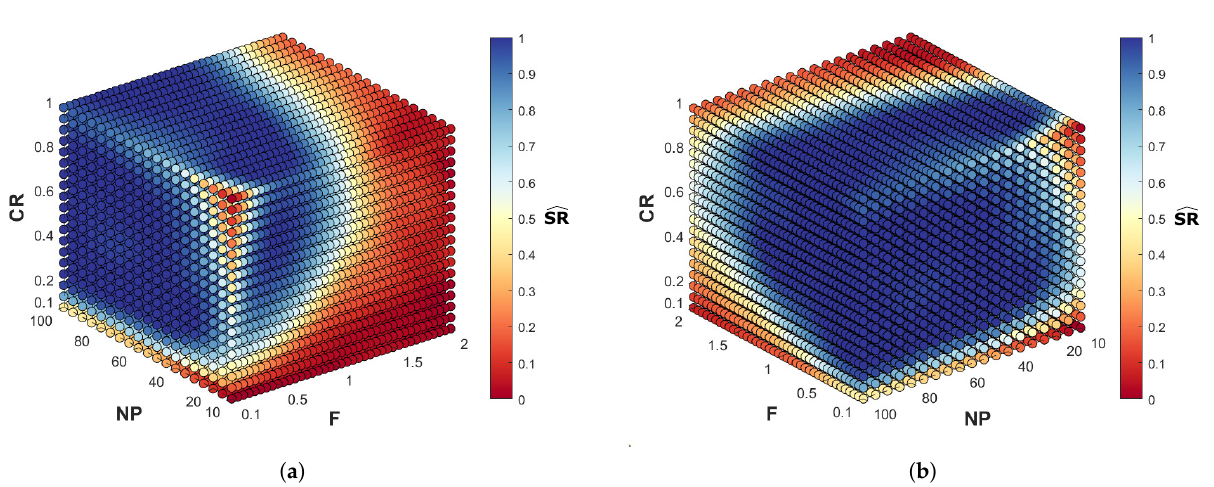
Figure 4. The illustration of 14,709 parameter combinations of Fcn1. Each point reflects a combination of NP, F and CR. The point color depends on (cid:99) SR precision value. The dark blue color means a high DE precision to achieve the requirements. The dark red color means a small DE precision to achieve the requirements: ( a ) first perspective, ( b ) second